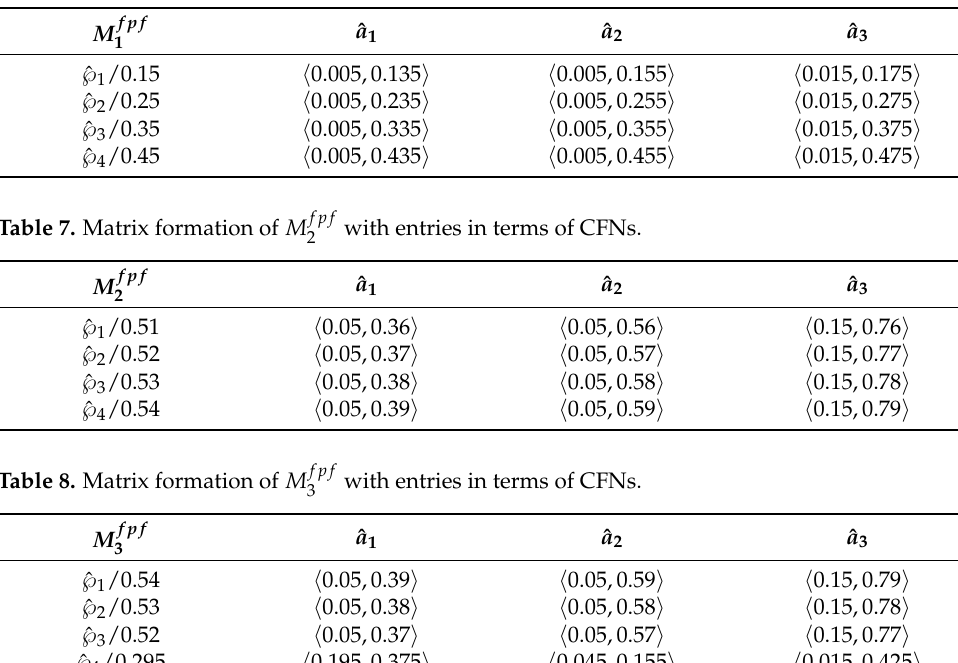
Table 6. Matrix formation of M fpf